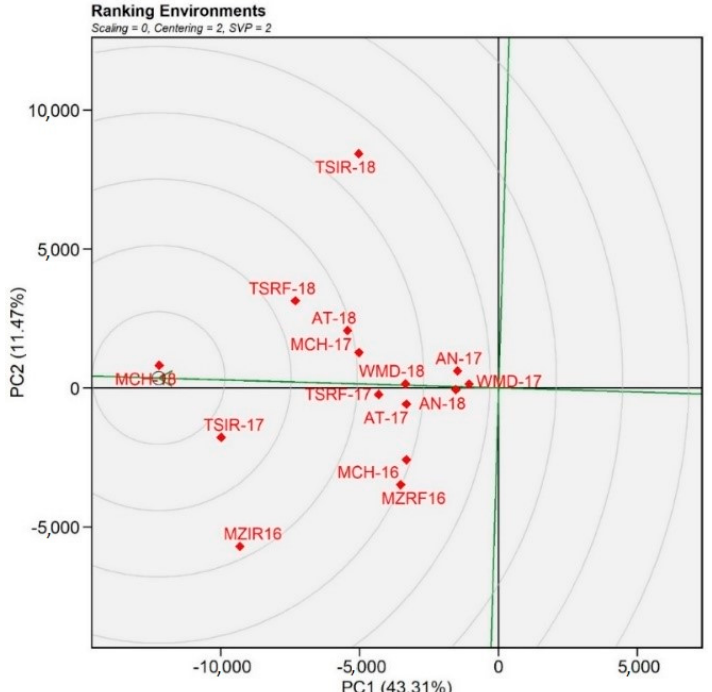
Figure 3. Genotype and genotype-by-environment (GGE) biplot for the ranking of the 15 testing environments based on their representativeness and discrimination ability. The green line with an arrow points to the smallest circle representing the average environment. The environments closer to the central circle are the best in terms of both discrimination and representativeness.